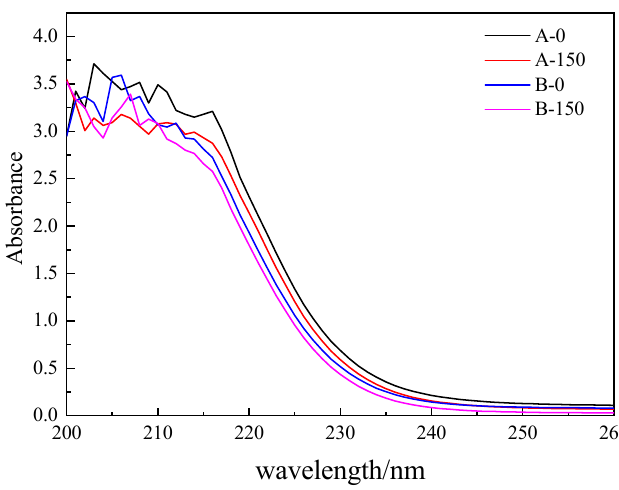
Figure 7. The UV-Vis absorption spectra before and after the photocatalytic reaction of SE-A and SE-B.